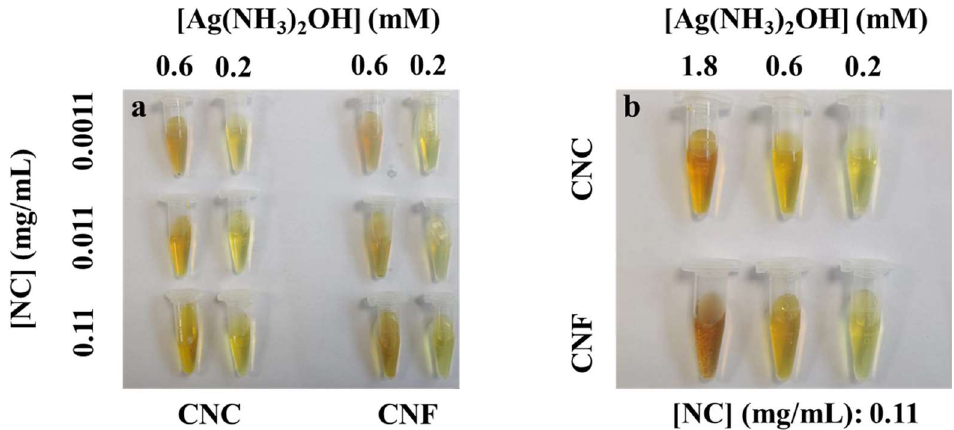
Figure 6. Pictures of NC-AgNPs system after 2.5 h reaction when the glucose concentration is 45 µ M. (( a ), When the concentrations of CNF and CNC in the mixed system are 0.0011 mg/mL, 0.011 mg/mL, 0.11 mg/mL respectively, and the concentrations of silver ammonia solution are 0.6 mM, 0.2 mM, respectively, the corresponding reaction color pictures; ( b ), When the concentration of CNF and CNC in the mixed system are 0.11 mg/mL and the concentration of silver ammonia solution are 1.8 mM, 0.6 mM and 0.2 mM respectively, the corresponding reaction color pictures).